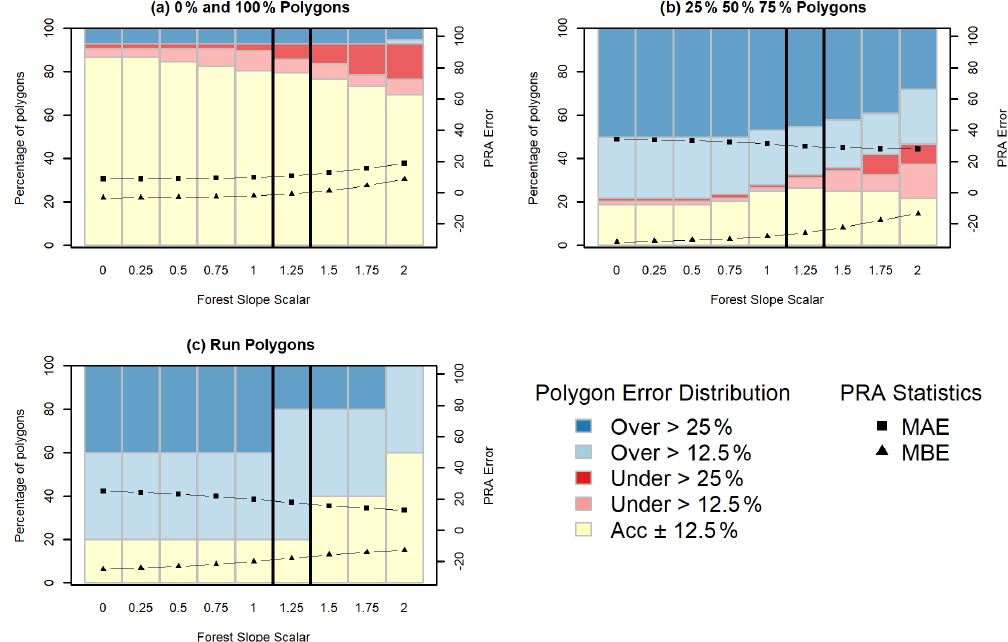
Figure 11. Frequent avalanche scenario PRA model grid search results for forest slope scalar with validation polygons split based on the type of